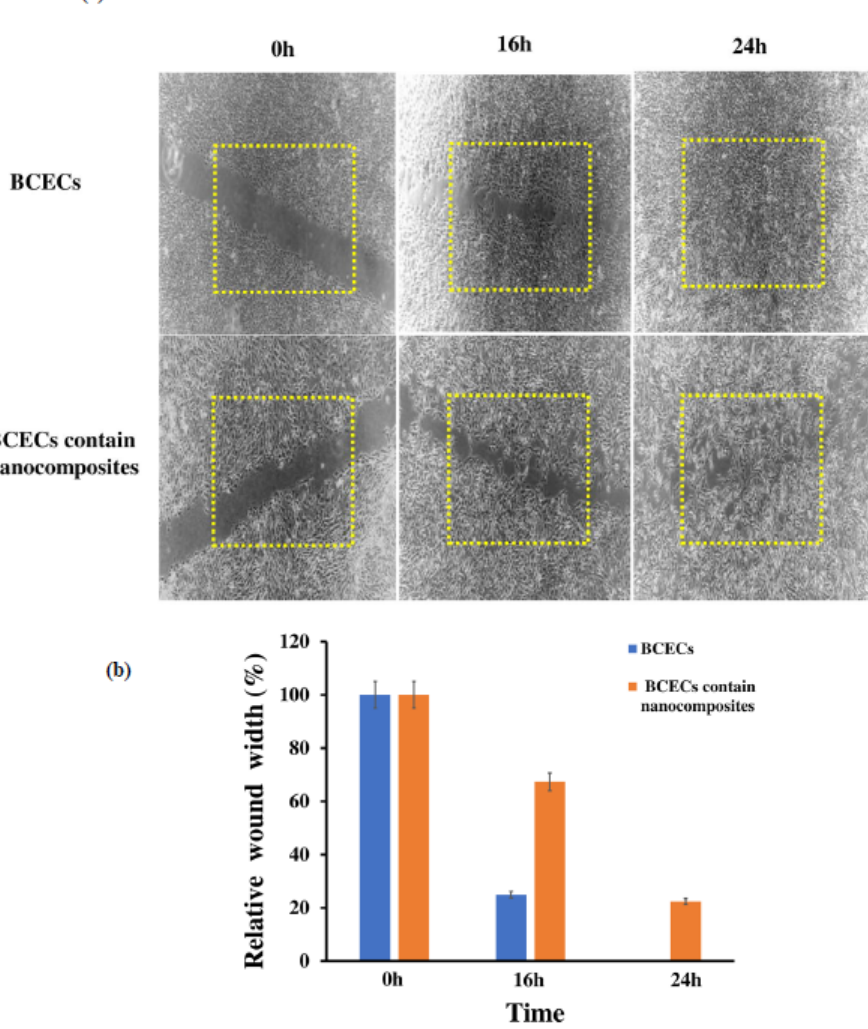
Figure 3. ( a ) The cell migration scratching assay on bovine cornea endothelial cells ( b ) quantitative analysis of BCECs migration represent the relative wound width calculated in relation to initial time (0 h). Results are expressed as mean ± SD repeated n = 3